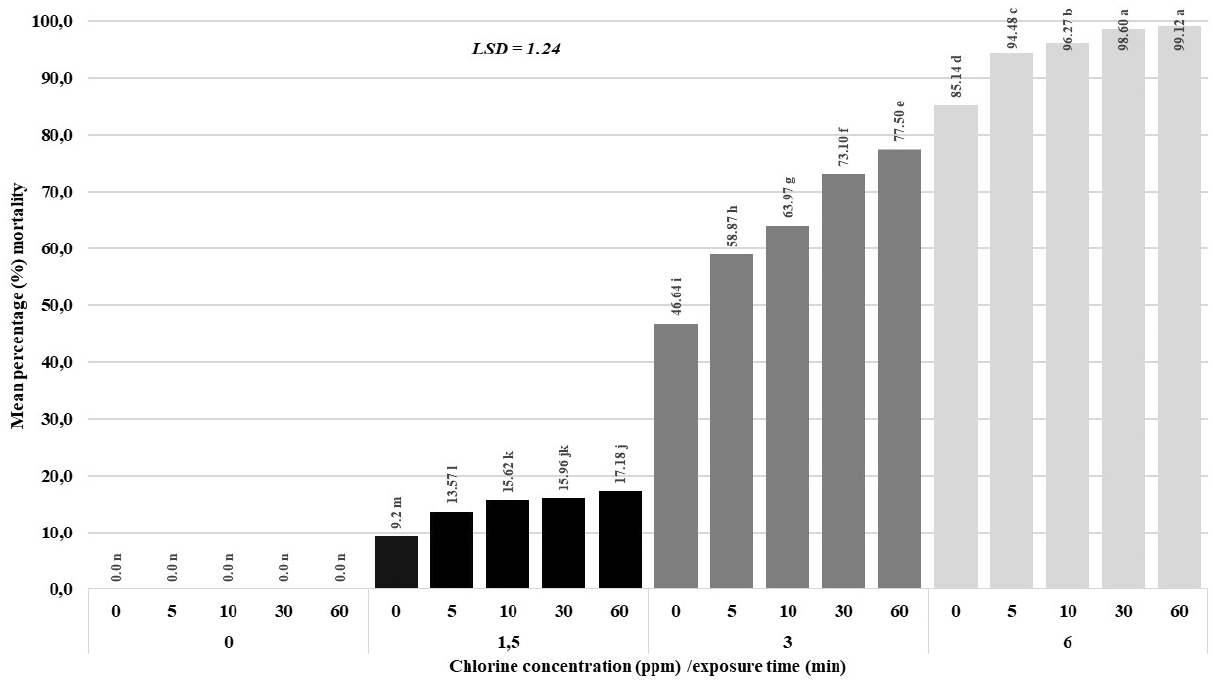
Figure 2. Mean percentage (%) mortality of Phytophthora spp. propagules exposed to 0, 1.5, 3 or 6 ppm active chlorine for exposure times of 0, 5, 10, 30 or 60